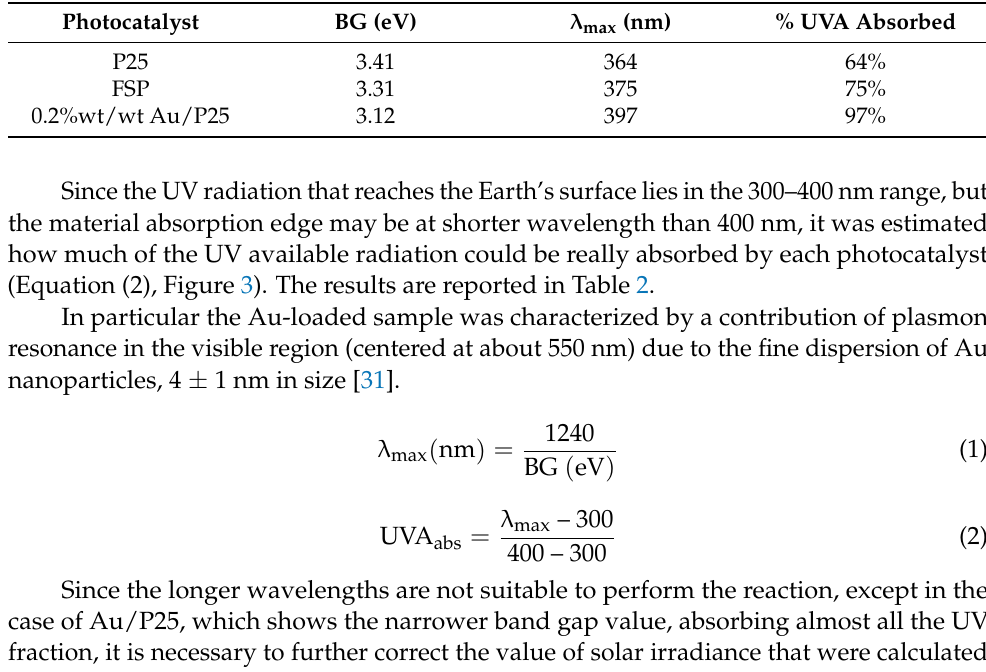
Table 2. Maximum light wavelength that can be absorbed by the listed photocatalysts and percentage of UVA radiation with the required energy to excite the electrons in such materials.